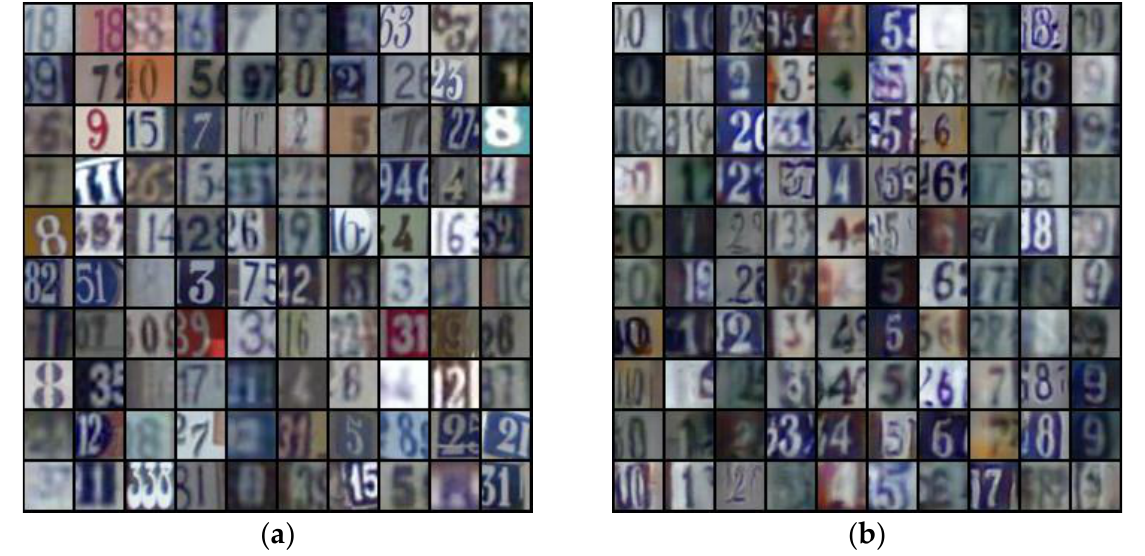
Figure 10. ( a ). some actual samples from the SVHN dataset. (b). artificial samples of SVHN gener- Figure 10. ( a ) some actual samples from the SVHN dataset. ( b ) artificial samples of SVHN generated ated by the image generation model. by the image generation model.